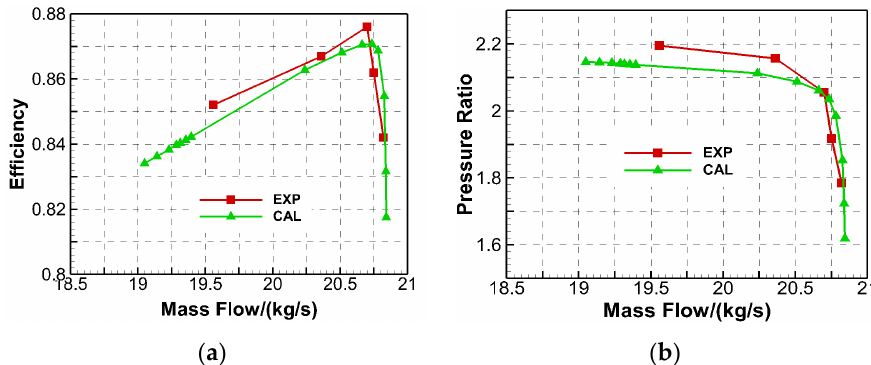
Figure 2. The comparison of the numerical simulation and the experimental results of Rotor37. ( a ) The isentropic efficiency; ( b ) the total pressure ratio.